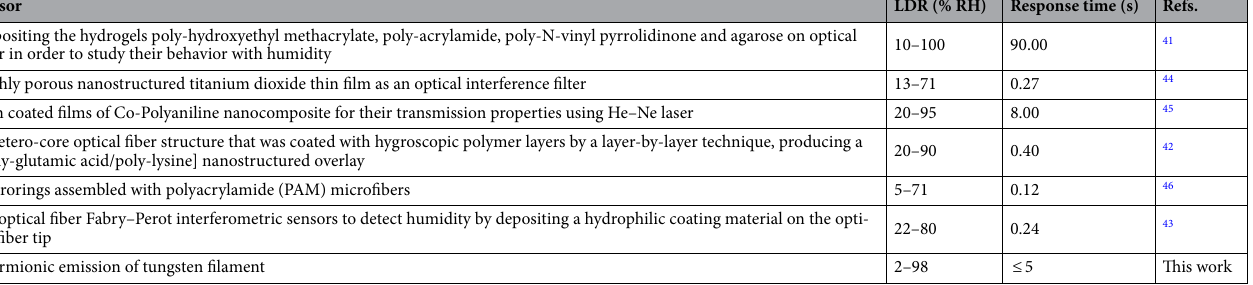
Table 1. Comparison between the developed sensor and other RH sensing probes reported in the literature.